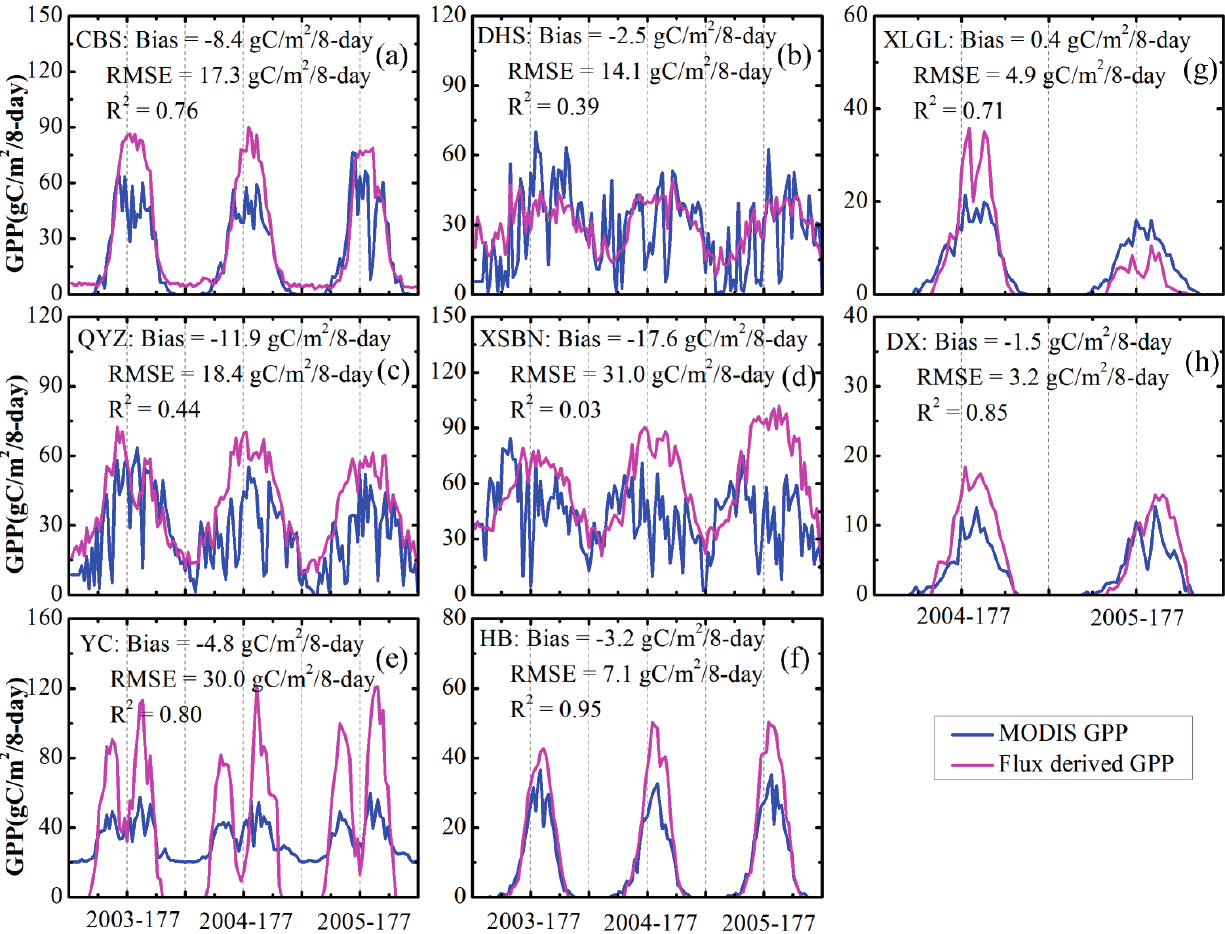
Figure 2. Comparison between the flux derived GPP (site name_derived) and MODIS-GPP (site name_MODIS) for all sites, pink solid line and blue solid line represent the flux derived GPP and MODIS-GPP, respectively. ( a ) in mixed forests site; ( b ) in evergreen broadleaf forests site; ( c ) in evergreen needleleaf forests site; ( d ) in evergreen broadleaf forests site; ( e ) in croplands; ( f , g , h ) in grasslands site. (DOY: Day of